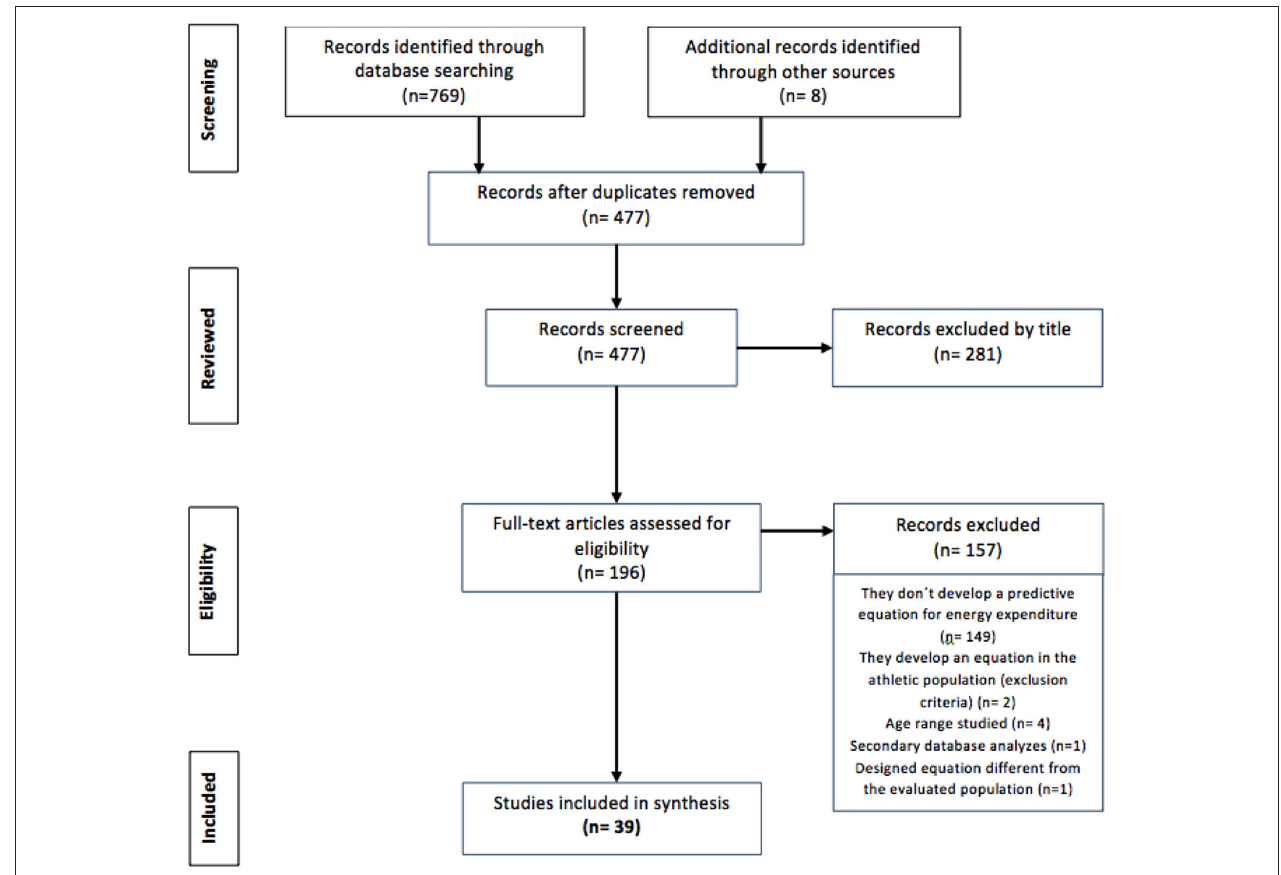
FIGURE 1 | PRISMA flow chart of the included